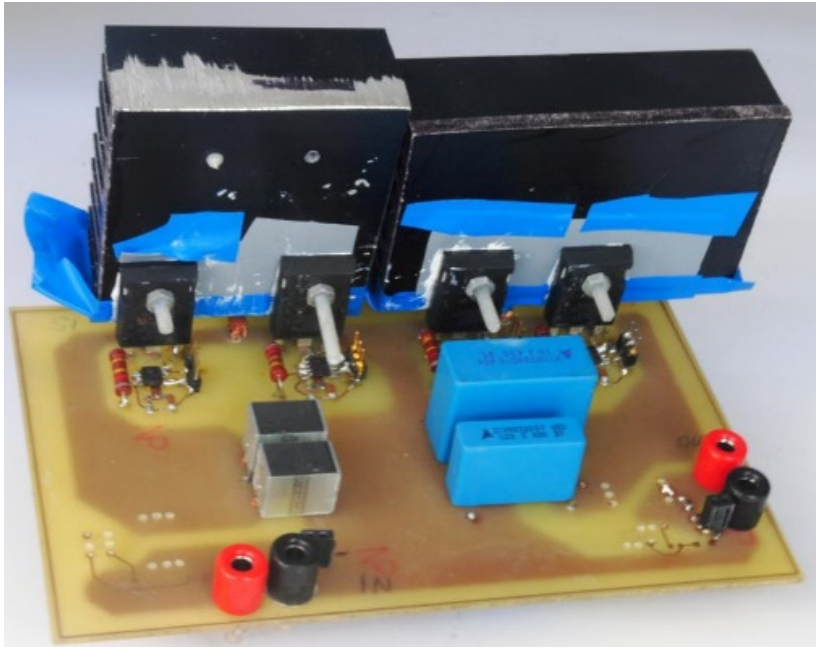
Figure 17. Picture of the 4SBB prototype.